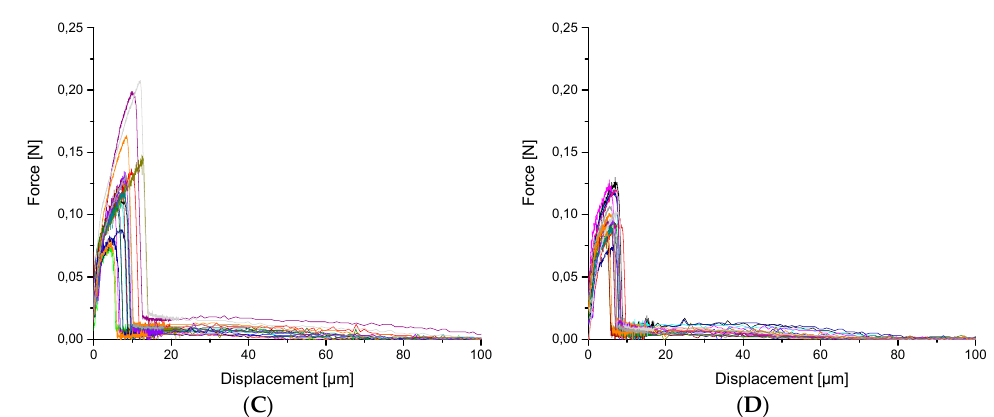
Figure 10. Force-displacement curves for I-CF00/000 (reference) ( A) , oxy-fluorinated samples with 1 vol% F 2 (I-CF01/180) ( B) , and 5 vol% F 2 (I-CF05/180) ( C) as well as a fluorinated CF (I-CF10/180) ( D) .